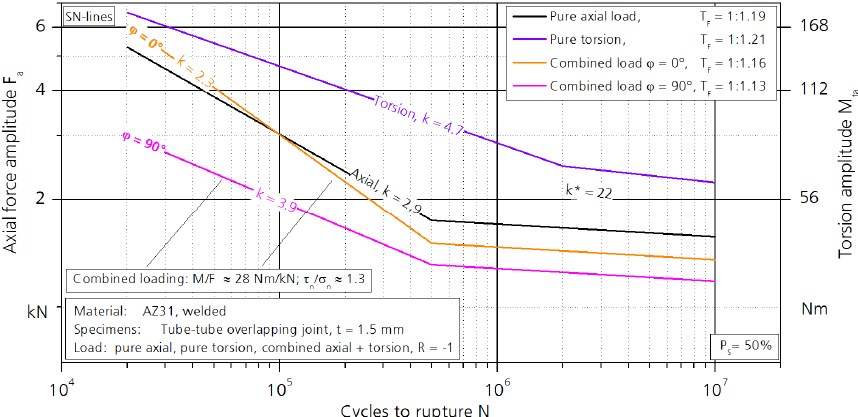
Figure 7: Experimental results for magnesium alloy AZ31 under constant